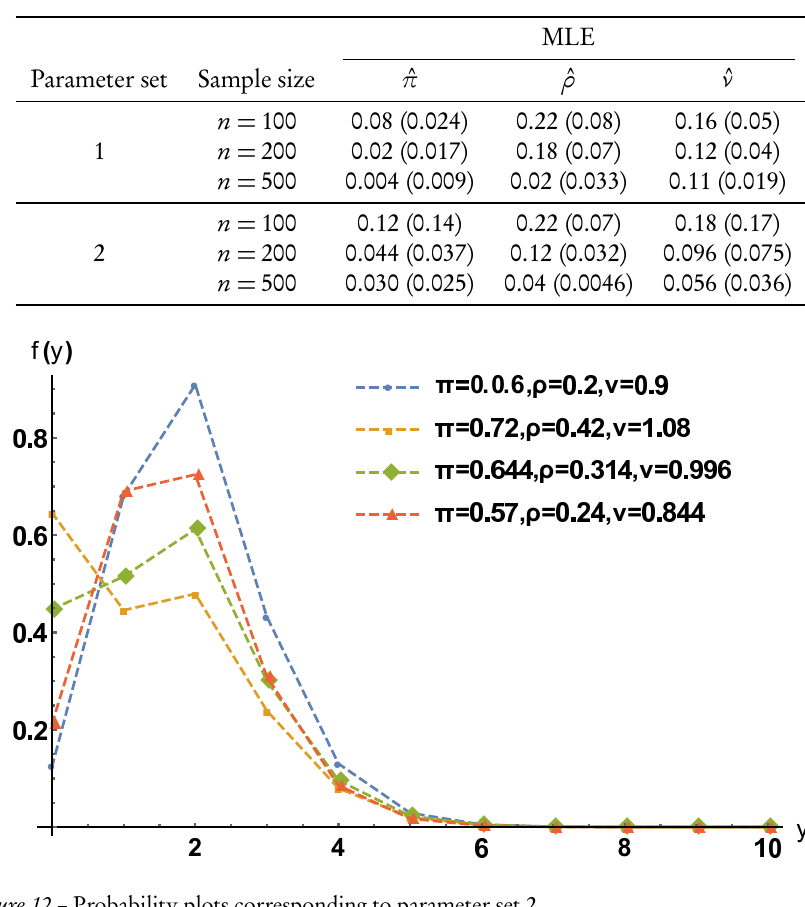
Absolute bias and standard errors (given in paranthesis) of each estimators of the ZIAHPD obtained by the method of maximum likelihood in case of parameter sets 1 and 2.